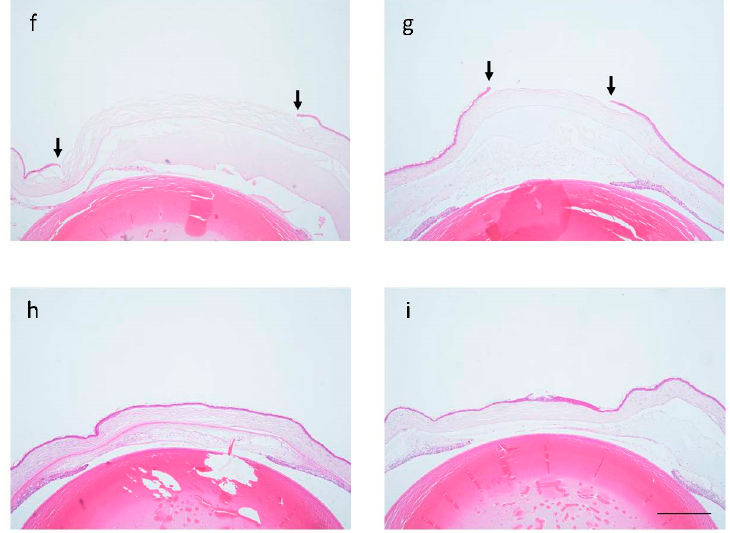
Figure 1. Images of the anterior eye of rats before and after alkali burn are shown. Before alkali burn ( a ). During alkali burn treatment ( b ). Immediately after alkali burn ( c ). At 7 days after alkali burn (Vehicle group) ( d ). At 7 days after alkali burn (disulfiram (DSF) group) ( e ). HE staining images of the central cornea, 6 h Vehicle group ( f ), 6 h DSF group ( g ), 1 day Vehicle group ( h ), 1 day DSF group ( i ). Bar, 500 μ m. The black arrows indicate the terminus of the corneal epithelium.